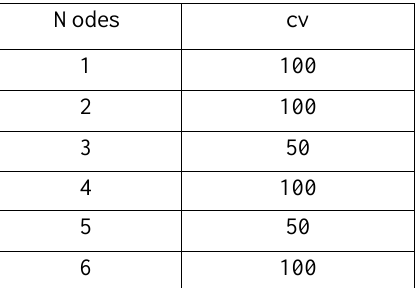
Table 1. Node flow capability